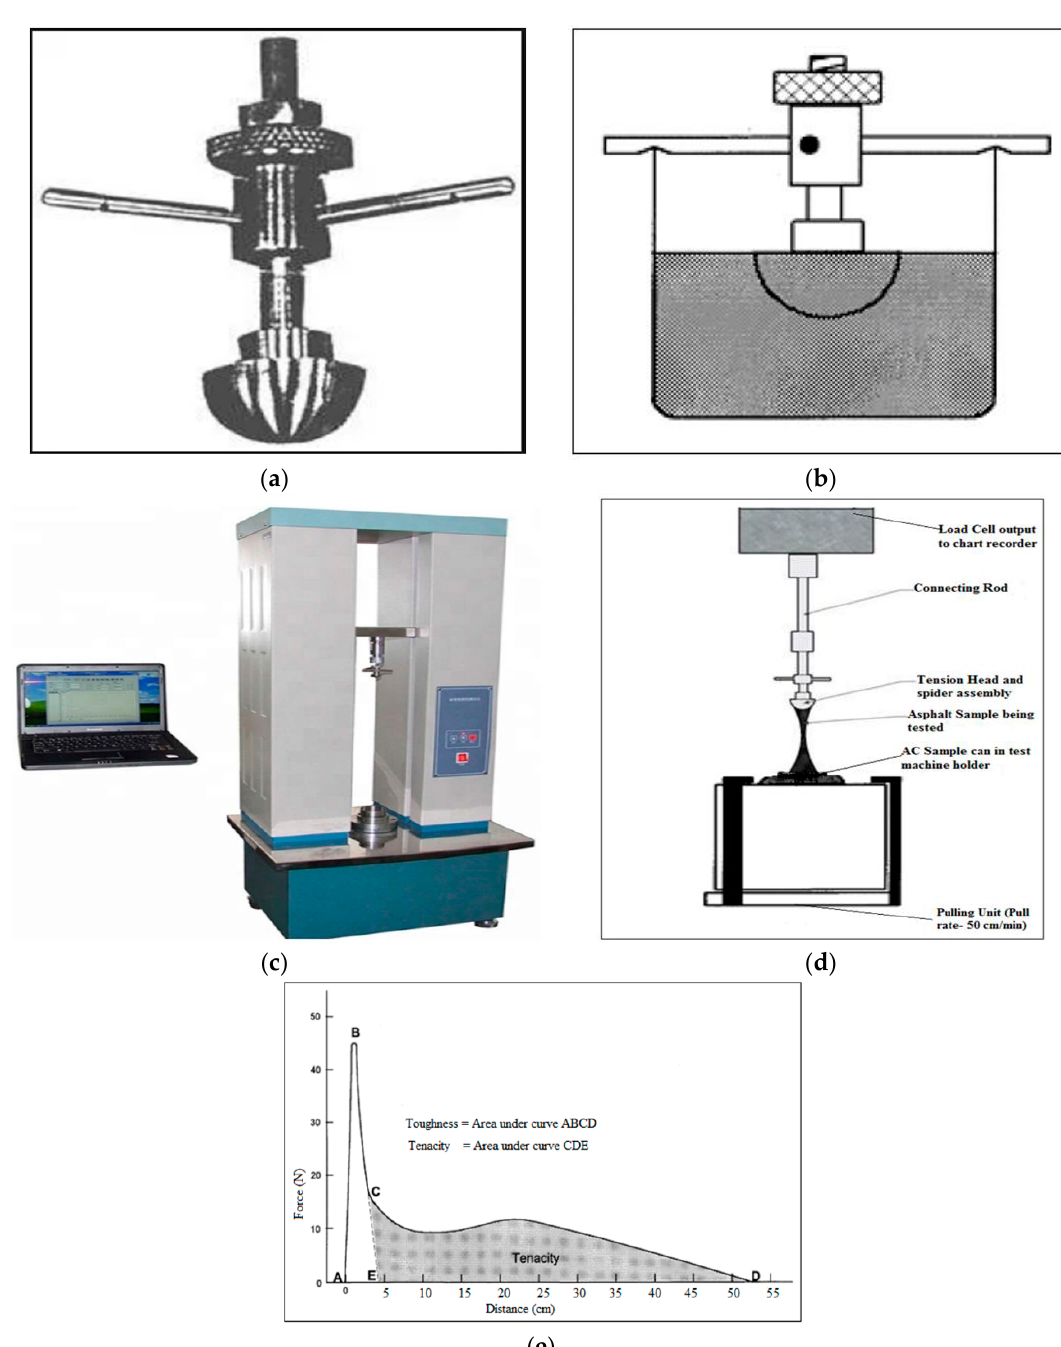
Figure 1. Apparatus for the toughness and tenacity test: ( a ) Tension head and spider; ( b ) proper position of tension head in asphalt sample; ( c ) testing machine; ( d ) asphalt sample under pulling force; and ( e ) chart for calculating toughness and